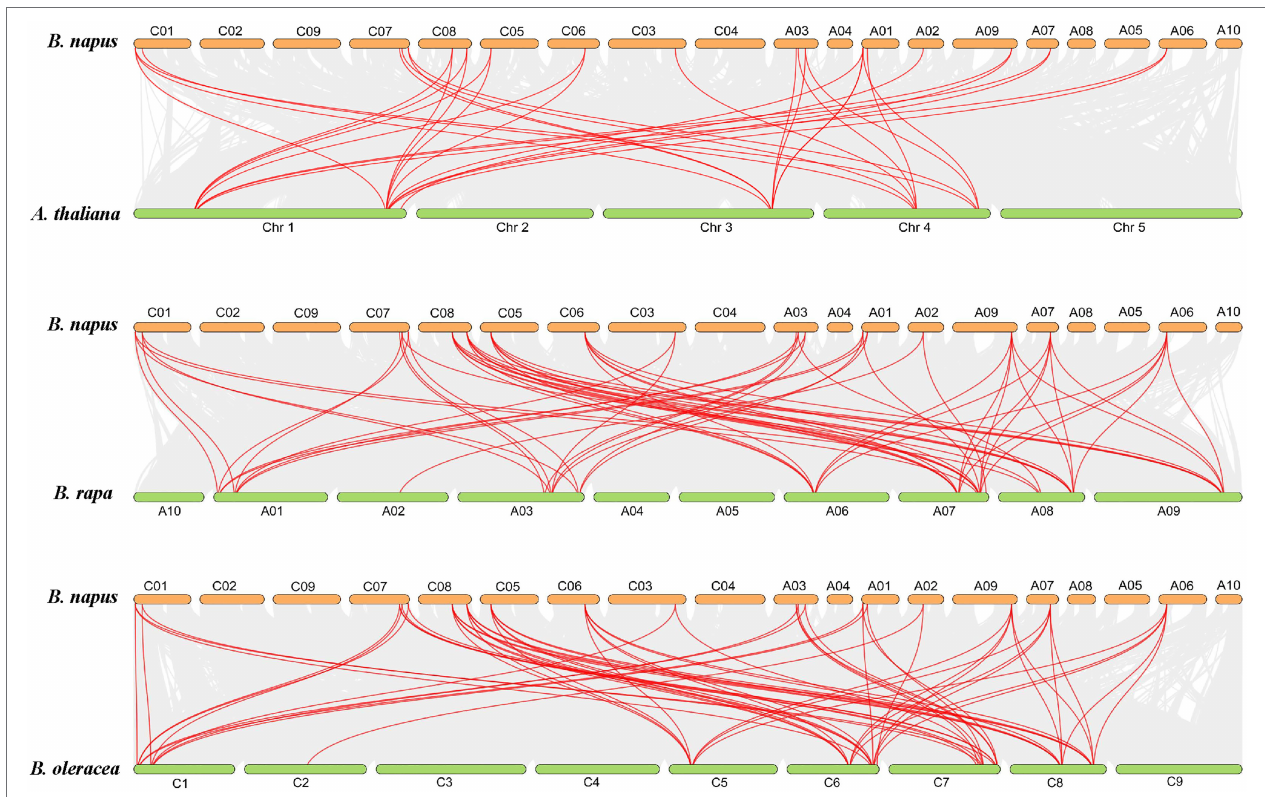
FIGURE 6 | Colinear gene pair analysis of BnaBZRs in B. napus in comparison with A. thaliana , B. rapa, and B. oleracea. The red lines indicate the collinear BZR gene pairs, and the gray lines indicate the collinear pairs within in the A. thaliana , B. napus , B. rapa , and B. oleracea genome.